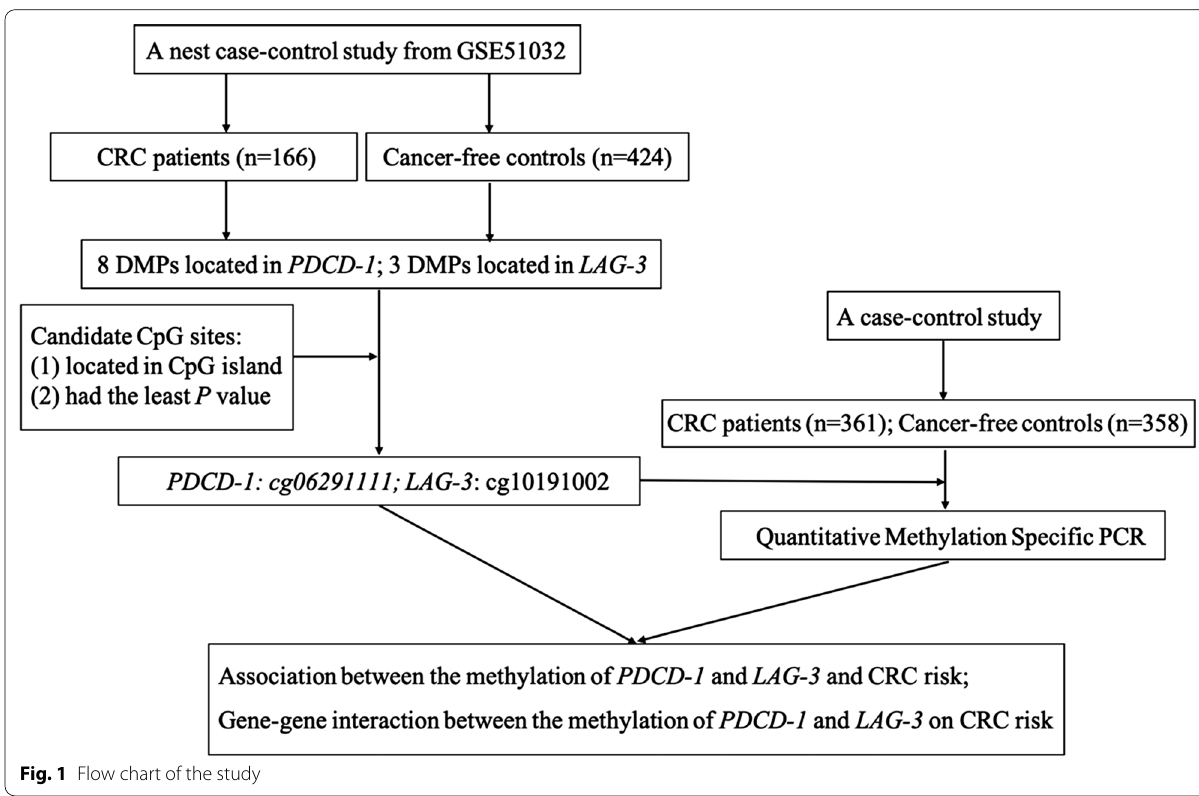
Fig. 1 Flow chart of the